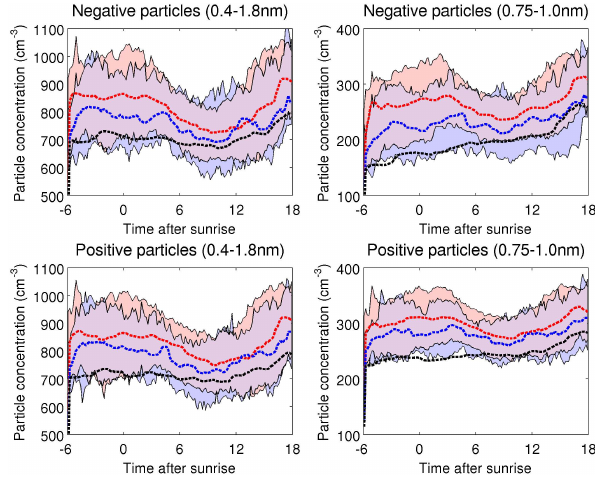
Fig. 4. Nucleation mode particles (3 to 25nm) measured with a DMPS. Higher concentrations of nucleation mode particles are nu- cleated on undercharged days (median, blue line) than on over- charged days (median, red line). The 25th to 75th percentiles range is given by blue and pink filled areas (purple is where both ranges are superposed).